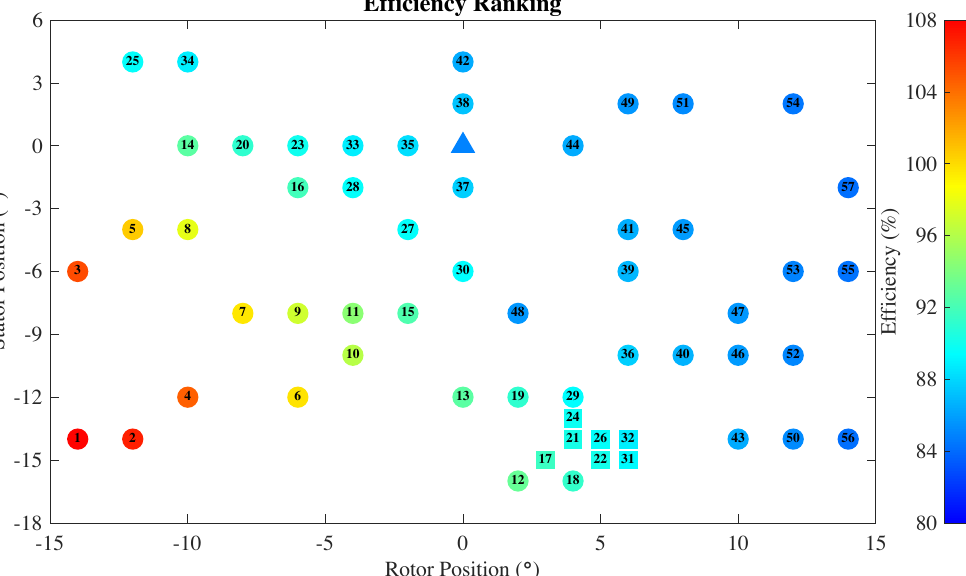
Figure 7. Scatter plot of the cases ranked by the adiabatic efficiency value with rank 1 being the highest. Cases in the initial data set are denoted by circles while the remaining cases are denoted by squares. The color fill of the circles and squares corresponds to the value of the adiabatic efficiency. The baseline design is denoted using a triangle with the efficiency value of η ref =